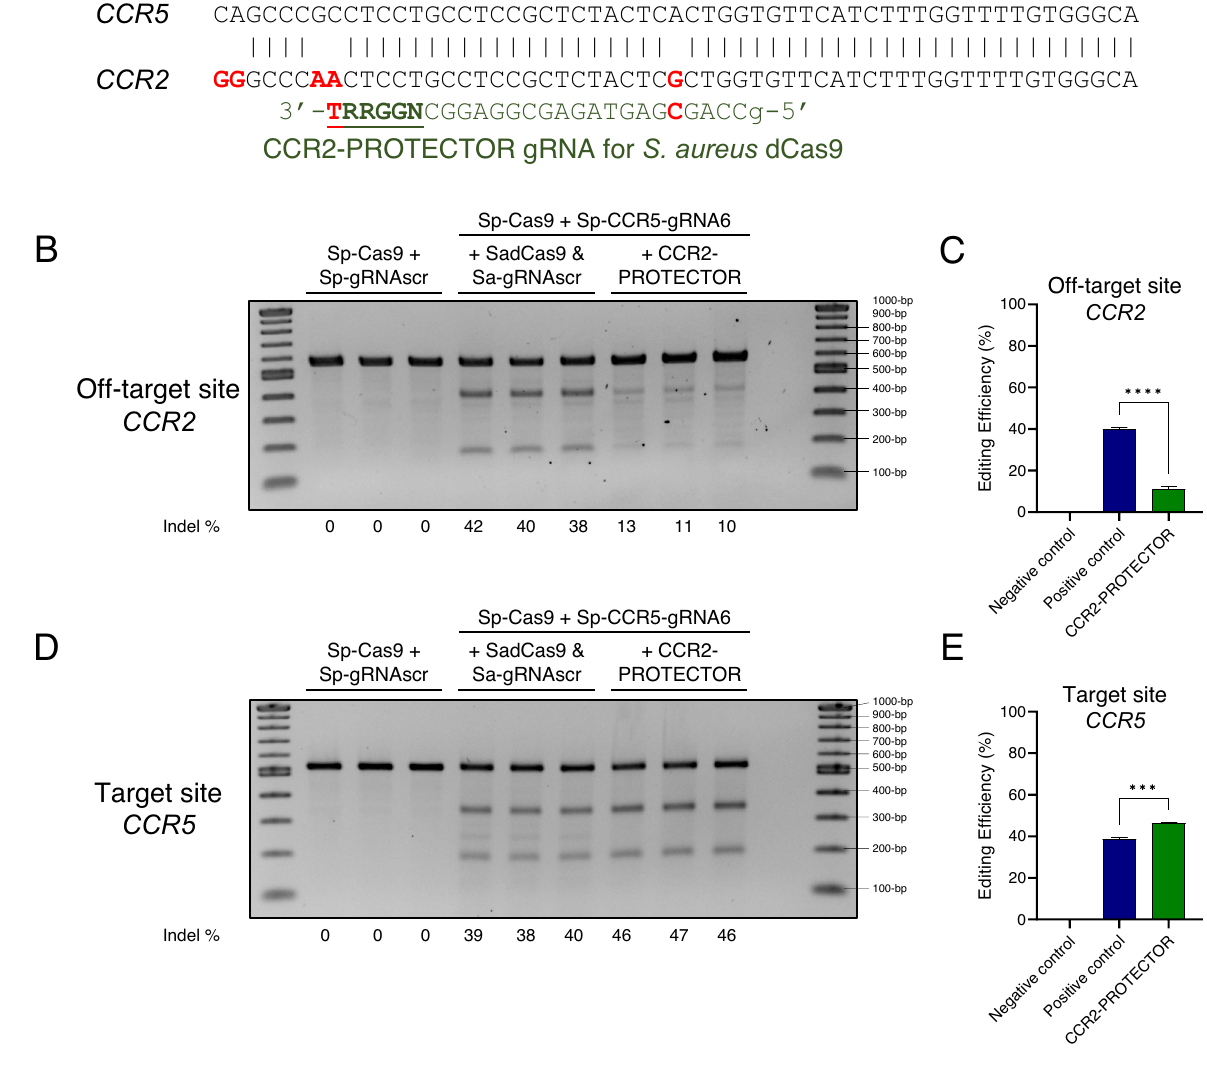
Figure 2. The PROTECTOR strategy applied to HEK293 cells transfected with CRISPR/Cas9 targeting CCR5 . ( A ) Schematic showing the specificity of the PROTECTOR gRNA for the off-target locus based on the sequence comparison between the target of Sp-CCR5-gRNA6 in the CCR5 gene and the off-target locus in the CCR2 gene. Mismatches in the CCR2 sequence are bolded and in red. Sp-CCR5-gRNA6 is depicted in blue with the PAM sequence bolded and underlined. The PROTECTOR gRNA is depicted in green with the PAM sequence bolded and underlined. Mismatches between the PROTECTOR gRNA sequence and the target site sequence are also bolded and in red. Agarose gel results of T7E1 assay for the off-target site in CCR2 and target site in CCR5 are depicted in ( B ) and ( D ). The first lane contains 1 kb Plus DNA Ladder (NEB), followed by results of T7E1 assays performed on the following biological triplicate sets of transfected samples: (1) summarized as “Negative control” in ( C ) and ( E ), HEK293 cells stably expressing dSaCas9 and PROTECTOR gRNA that were transfected with 250 ng SpCas9 plasmid and 250 ng scrambled non-targeting Sp-gRNA plasmid (Sp-gRNAscr), (2) summarized as “Positive control” in ( C ) and ( E ): HEK293 cells stably expressing dSaCas9 and scrambled non-targeting Sa-gRNA, transfected with 250 ng SpCas9 plasmid and 250 ng Sp-CCR5-gRNA6 plasmid, and (3) summarized as “CCR2-PROTECTOR” in ( C ) and ( E ), HEK293 cells stably expressing dSaCas9 and PROTECTOR gRNA, transfected with 250 ng SpCas9 plasmid and 250 ng Sp-CCR5-gRNA6 plasmid. The final two lanes contain a negative (water) control for the T7E1 assay followed by 1 kb Plus DNA Ladder. Indel estimates for each sample are depicted at the bottom of each lane, rounded to the nearest whole number. The results of ( B ) and ( D ) are quantified in ( C ) and ( E ), respectively. Data in ( C ) and ( E ) are presented as mean ± SEM and were quantified with ImageJ: editing efficiency is calculated as the intensity of T7E1 cleavage products divided by the sum of the intensities of T7E1 cleavage products and the uncut PCR amplicon. **** represents p < 0.0001 and *** represents p < 0.001 by independent